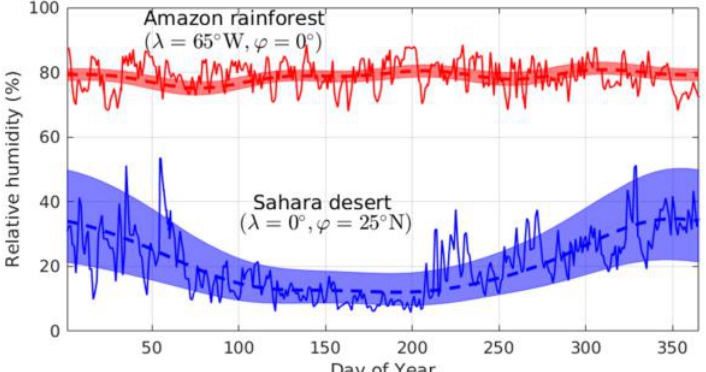
Figure 3. Relative humidity at two distinct locations with different climatological and topographical characteristics. In blue: over the Sahara Desert ( λ = 0 ◦ , φ = 25 ◦ N), and in red: over the Amazon Rainforest ( λ = 65 ◦ W, φ = 0 ◦ ) during 1 year (2020). The bluish shaded area represents the diurnal cycle, obtained using Equation (7). The dashed line represents the model daily mean, and the continuous line represents the daily mean of ERA5